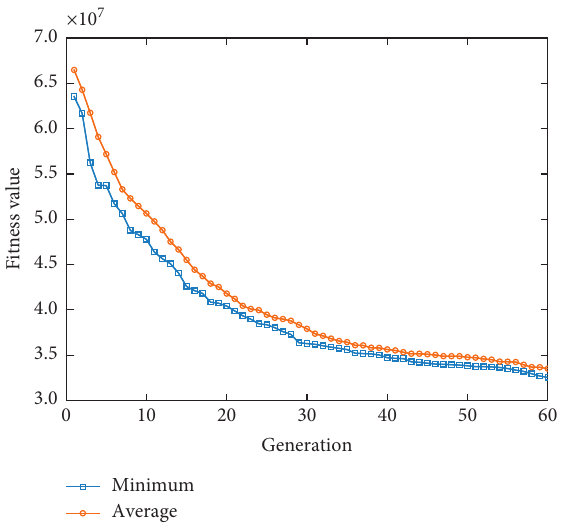
Figure 6: Convergence trend of the genetic